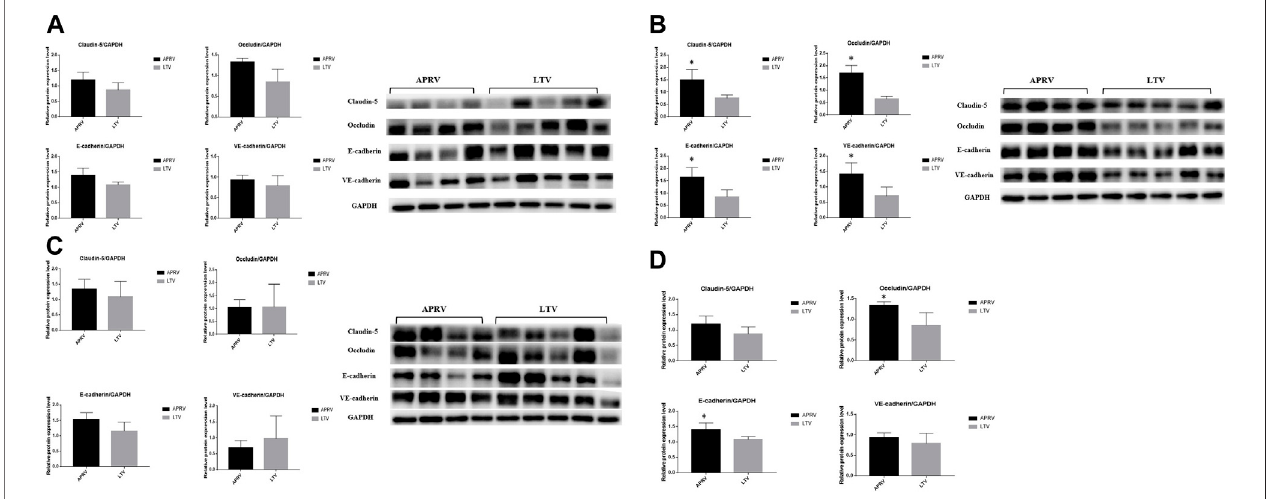
FIGURE 5 | Protein expression level of biomarkers in the lung. Western blot analysis of claudin-5, occludin, E-cadherin, and VE-cadherin in the pig lung tissue. (A) Polyacrylamide gel electrophoresis and protein expression levels of claudin-5, occludin, E-cadherin, and VE-cadherin in the upper lobe of the right lung. (B) Polyacrylamide gel electrophoresis and protein expression levels of claudin-5, occludin, E-cadherin, and VE-cadherin in the middle lobe of the right lung. (C) Polyacrylamide gel electrophoresis and protein expression levels of claudin-5, occludin, E-cadherin, and VE-cadherin in the lower lobe ofthe right lung. (D) Protein expressionlevelsofclaudin-5,occludin,E-cadherin,andVE-cadherininthewholerightlung.TheaverageWBresultsoftheupper,middle,andlowerlobesweretakento compare the expression of protein in the whole lung. * p < 0.05. APRV, airway pressure release ventilation; LTV, low tidal volume ventilation.